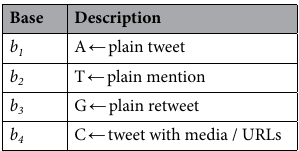
Table 1. Labelling and descriptions of DNA base in user